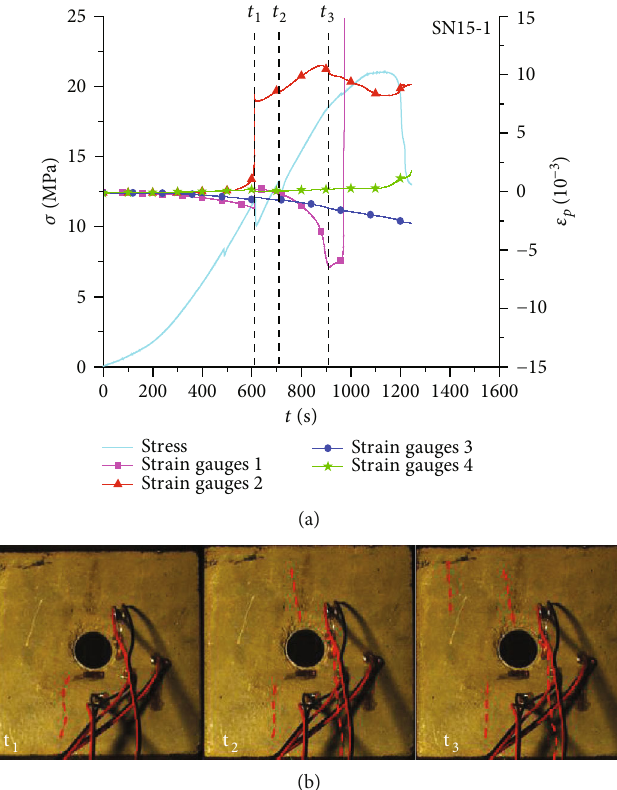
Figure 12: (a) Relationship between local strain and stress of specimen SN15-1 with loading time. (b) The relationship between the crack growth shape of specimen SN15-1 and loading